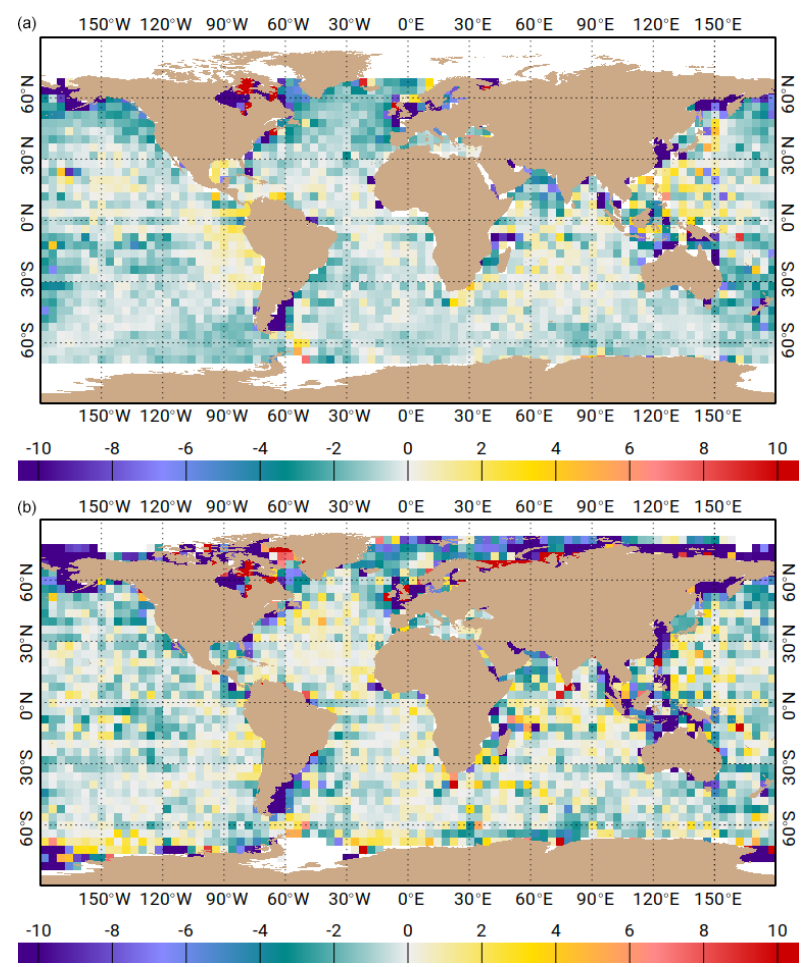
Figure 15. Maps of SSH variance differences at crossovers using either the FES2014b tidal atlas or the GOT4v10 atlas in the SSH calculation for the Jason-2 mission ( a , J2 cycles 1–281) and for AltiKa ( b , AL cycles 1–21, in cm 2 ). Blue colours indicate a higher variance reduction when using FES2014b tidal correction. Tidal corrections made for both models with their native constituents’ spectrum (i.e. not restricted to their common